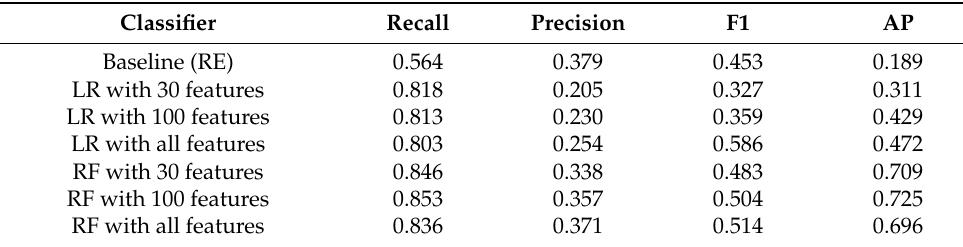
Table 4. Classifier performance for different feature